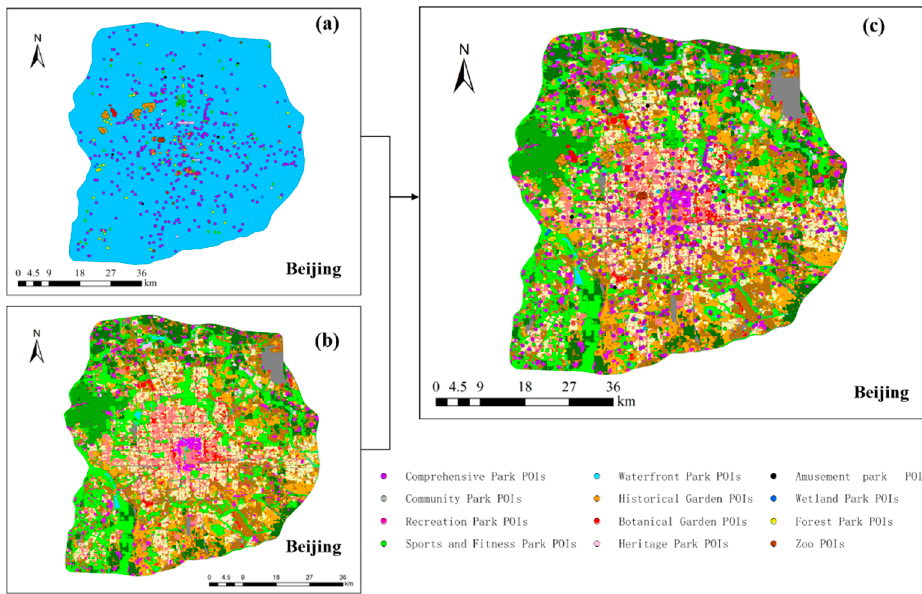
Figure 8. Multi-source data fusion process of Beijing. ( a ) POI data of urban parks, ( b ) urban functional zone (UFZ) data, and ( c ) data synthesis image.